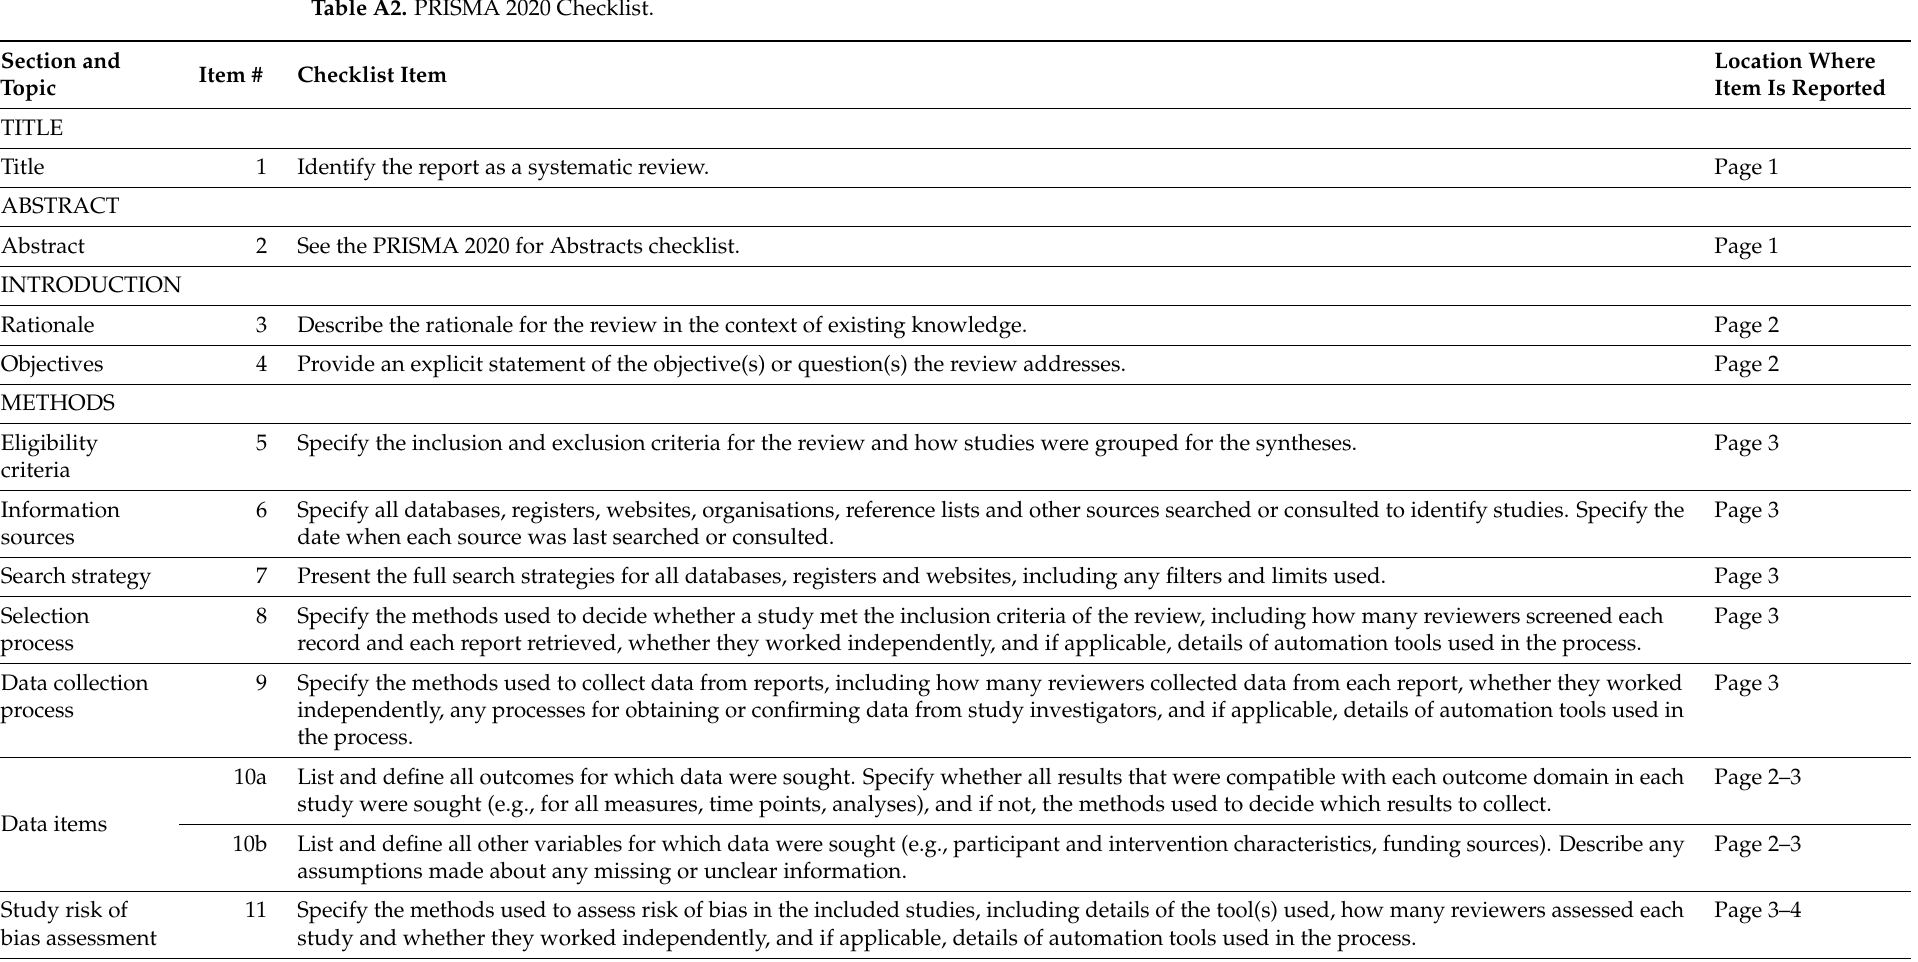
Table A2. PRISMA 2020